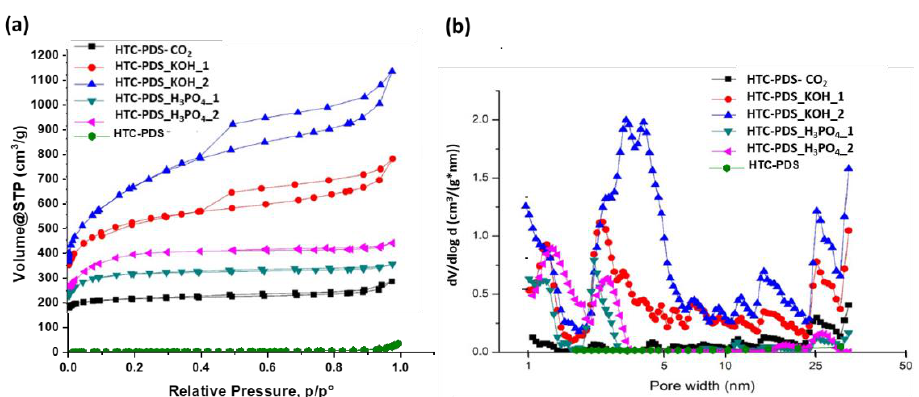
Figure 3. ( a ) N 2 sorption isotherms and ( b ) the pore size distributions of the HTC-PDS and respective activated materials. activated materials. The measurements were performed at − 196 ◦ C with N 2 . The measurements were performed at − 196 °C with N 2 . Table 2. Textural properties of the HTC-PDS-activated materials. * µ V = micropore volume.